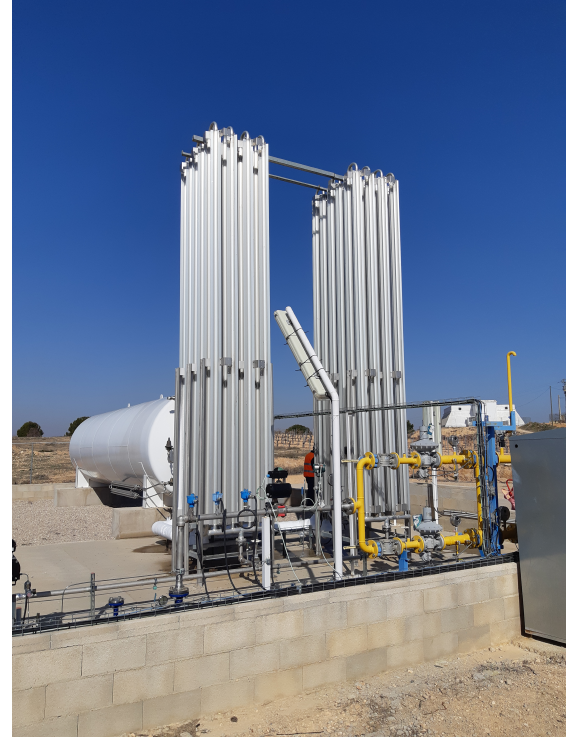
Figure 1. Satellite liquid natural gas (LNG) plant.